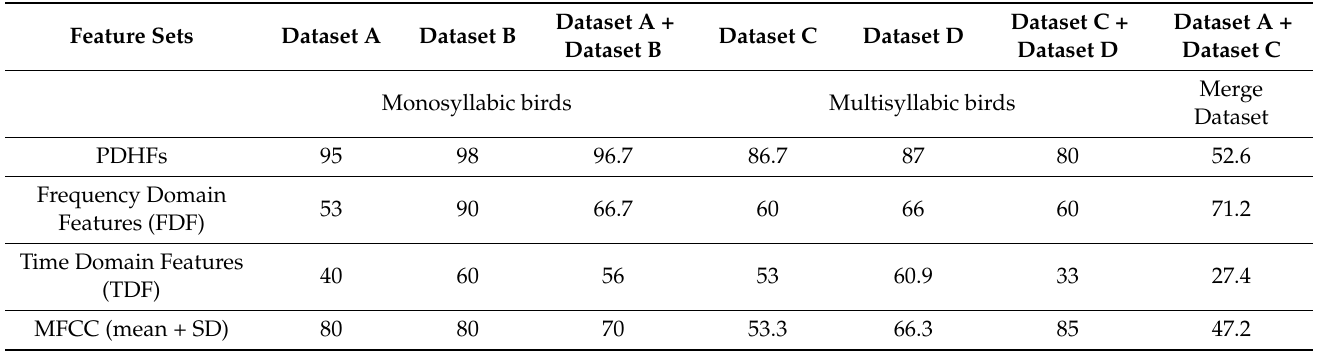
Table 7. The performance of different feature vectors to classify different datasets of monosyllabic and multisyllabic birds through ANN.